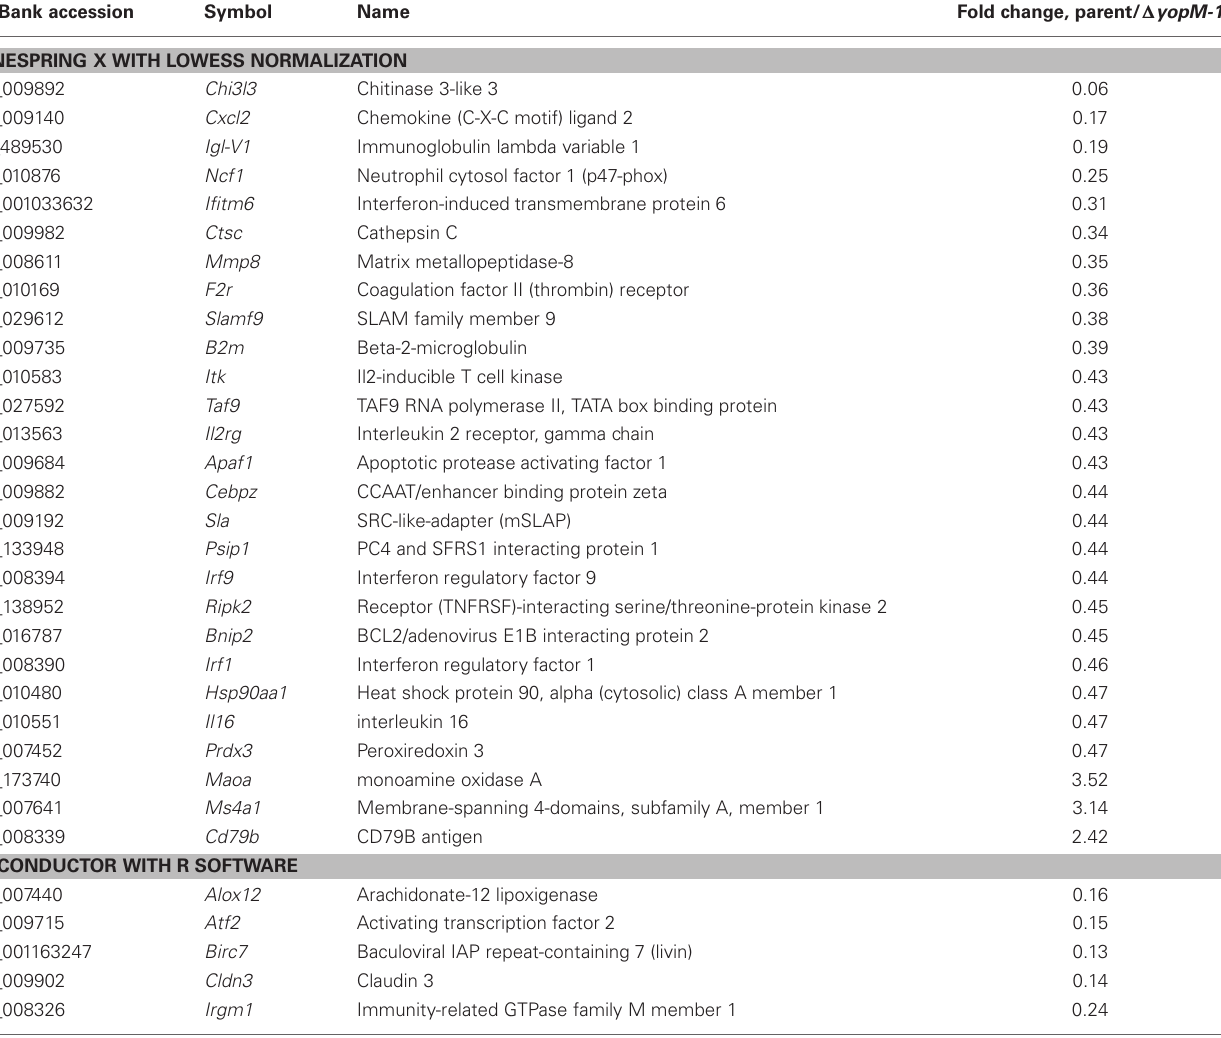
Table 7 | Microarray results for 18-h infection, analyzed two ways a . GenBank accession Symbol Name Fold change, parent/ (cid:3) yopM-1 GENESPRING X WITH LOWESS